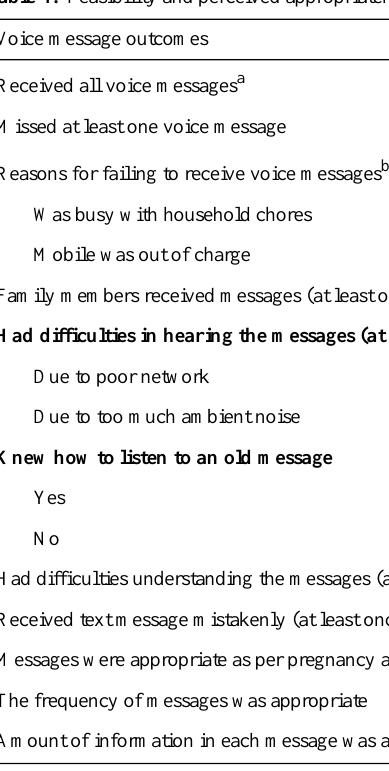
Table 4. Feasibility and perceived appropriateness of nutrition education through mobile voice messaging